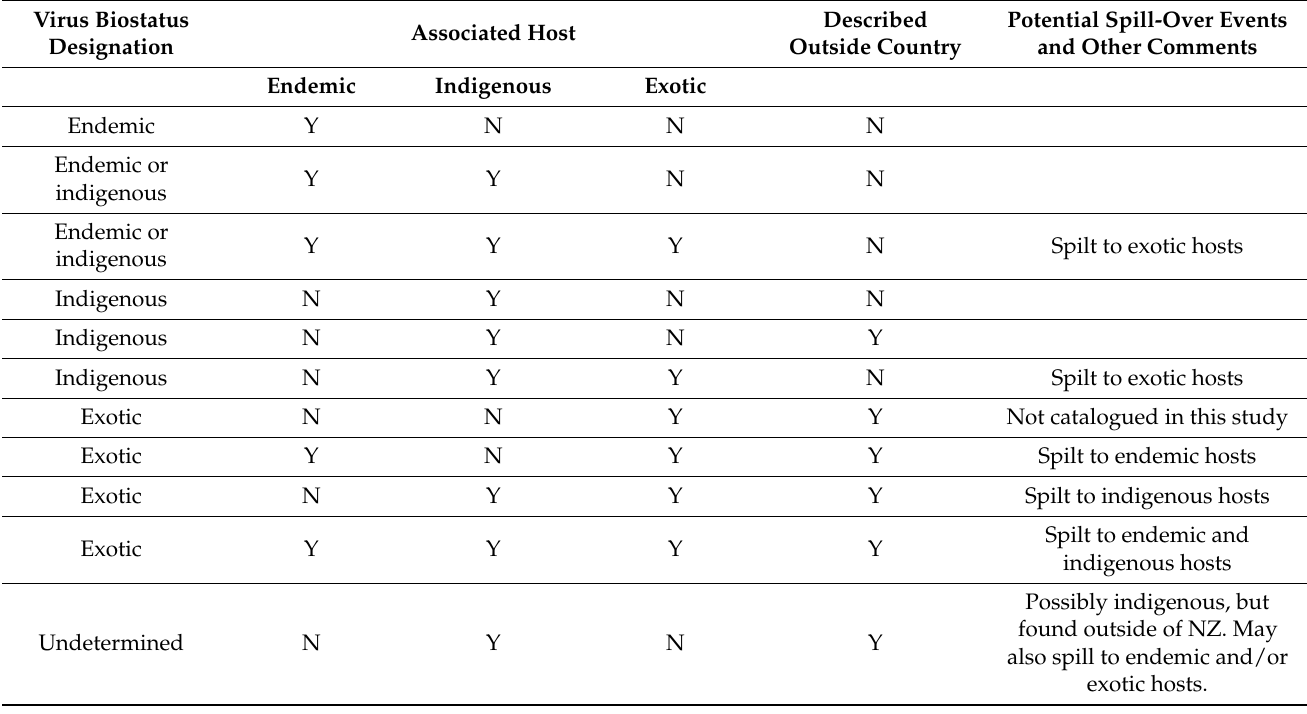
Table 1. Virus biostatus designations used in this study. Designations change as more information on virus evolutionary history, hosts, and biogeography are